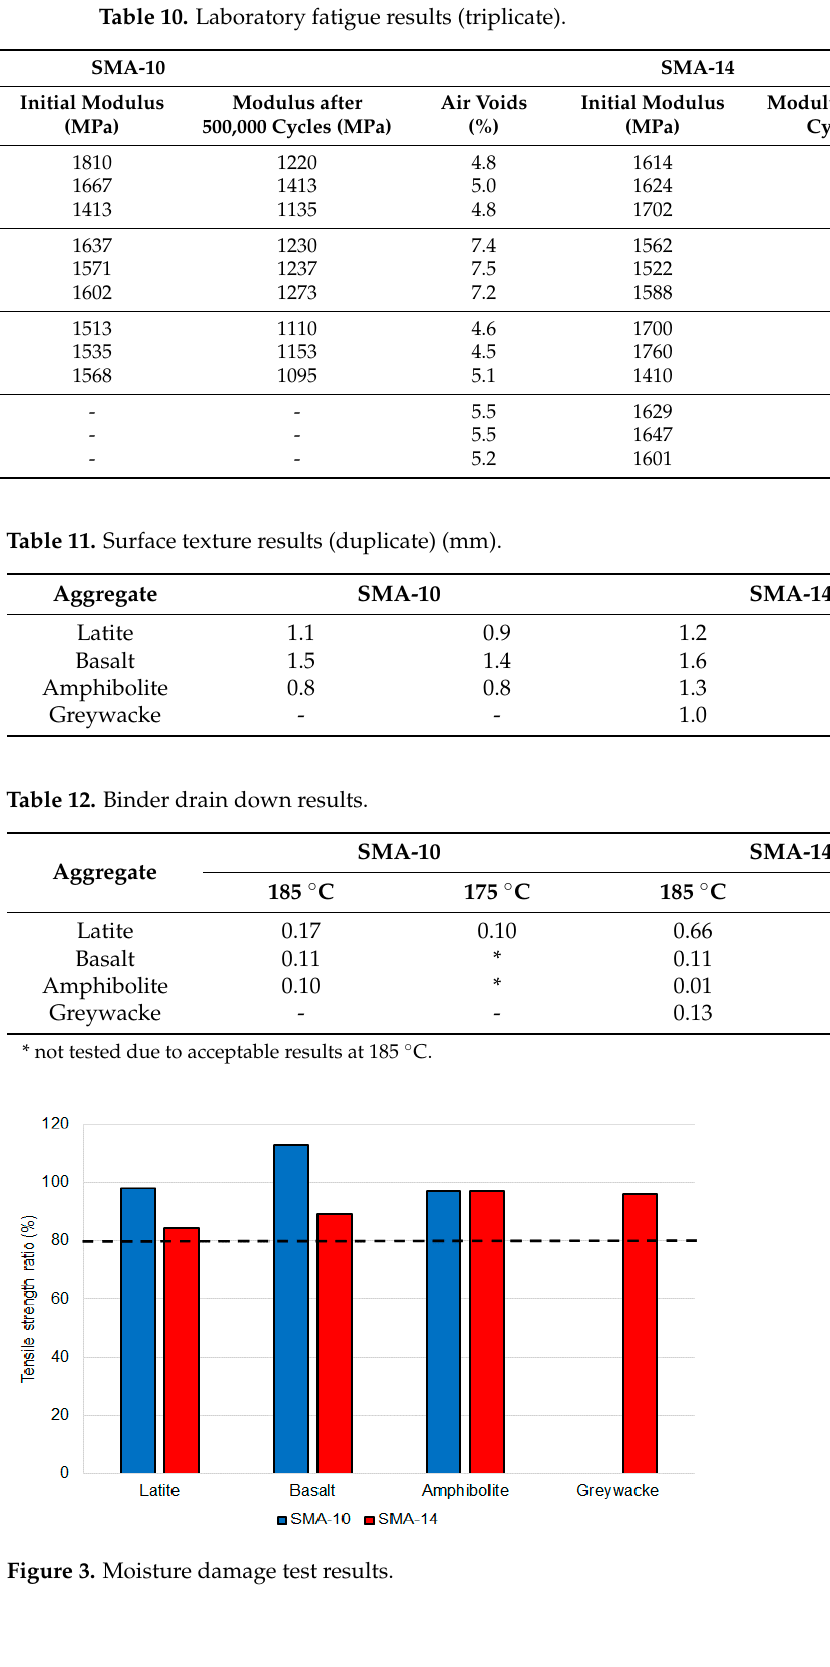
Table 10. Laboratory fatigue results (triplicate).